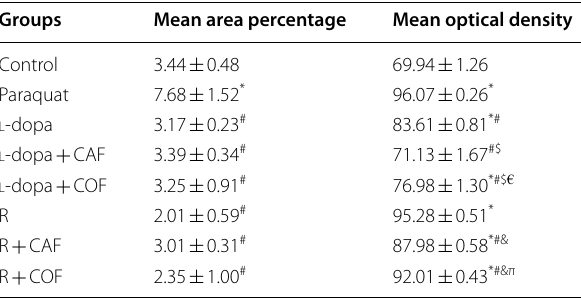
Values are presented as mean S.E.M. *Significant from normal group P < 0.05. ± # Significant from paraquat group P < 0.05. $ Significant from l -dopa group P < 0.05. € Significant from l -dopa CAF group P < 0.05. & Significant from R group + P < 0.05. π Significant from R CAF group P < +